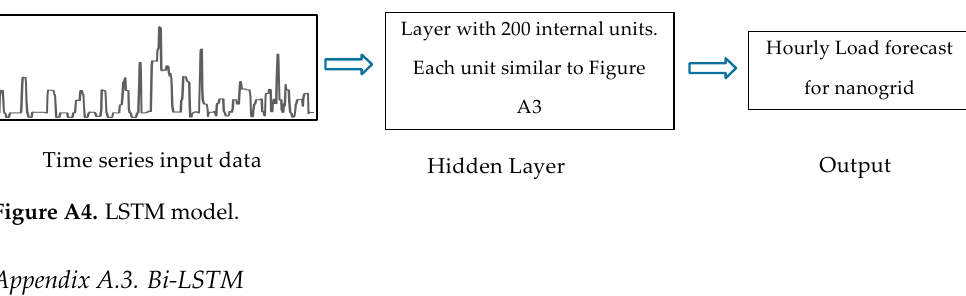
Figure A4. LSTM model.